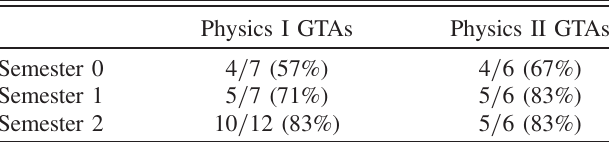
TABLE IX. Results from Kruskal-Wallis and Dunn ’ s tests with Holm-Bonferroni correction. * p < 0 . 05 . ** p < 0 . 01 . *** p < 0 . 001 . † small effect size. †† medium effect size. ††† large effect size. The p values from Dunn ’ s tests are bolded if the difference is significant at the 0.05 level with Holm-Bonferroni correction.